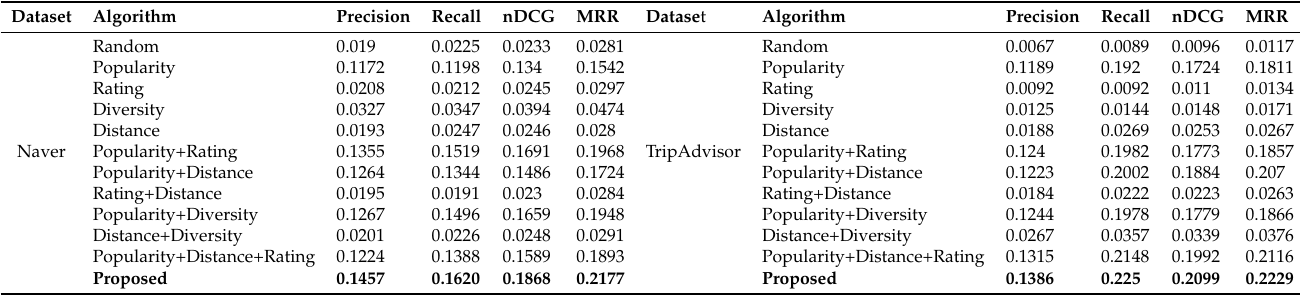
Table 6. Top 2 recommendation accuracy comparison.